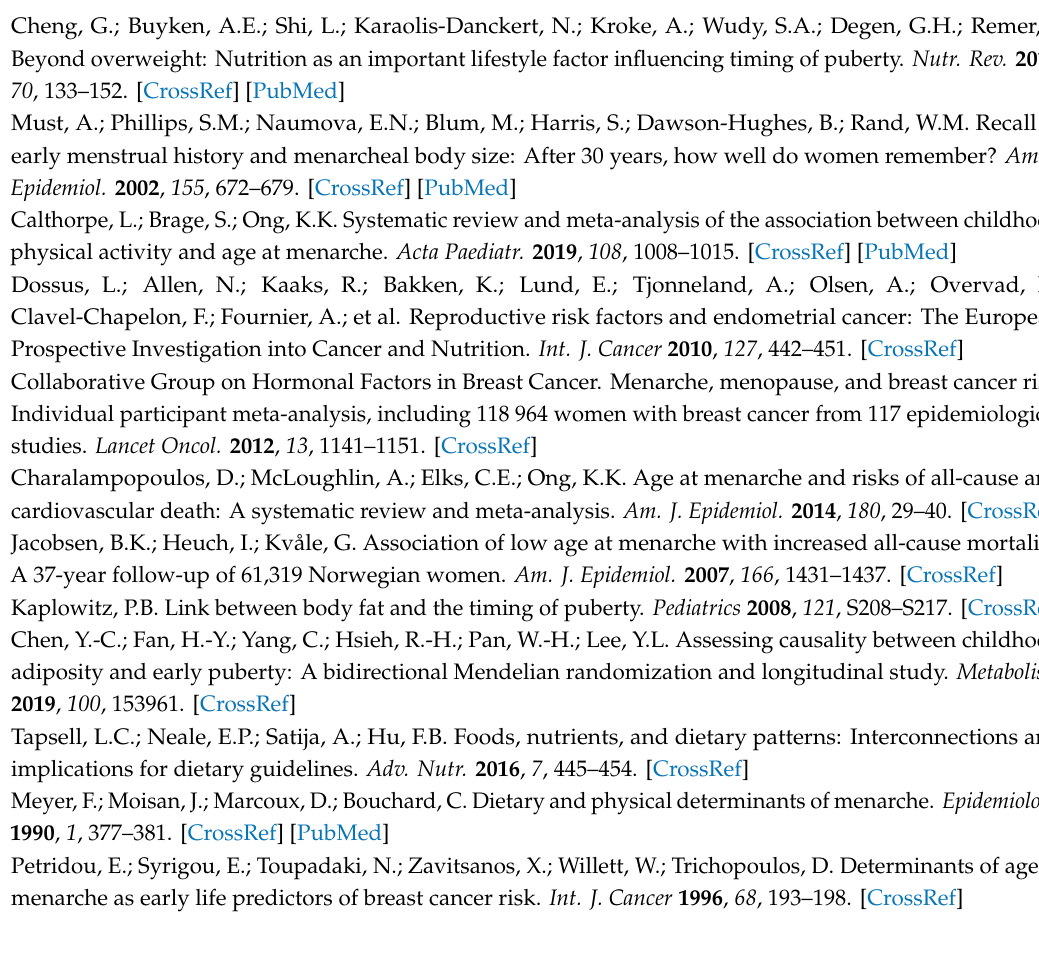
Table S1: PECOS criteria for inclusion and exclusion criteria, Table S2: Quality assessment of the included studies using a modified Quality Assessment Tool for Systematic Reviews of Observational Studies (QATSO) Score for assessing relationship between prepubertal nutrient intake and EMO, Table S3: Analyses of publication bias using Egger Test for assessing relationship between prepubertal nutrient intake and EMO, Table S4: Univariate meta-regression analyses, Table S5: Association between EMO and quartile of nutrient intake in childhood, Figure S1: Forest plot of mean di ff erences of carbohydrate, total fat, and protein intake between EMO and NEMO among girls with BMI < 18.5 kg / m 2 , Figure S2: Association between EMO and quartile of nutrient intake in